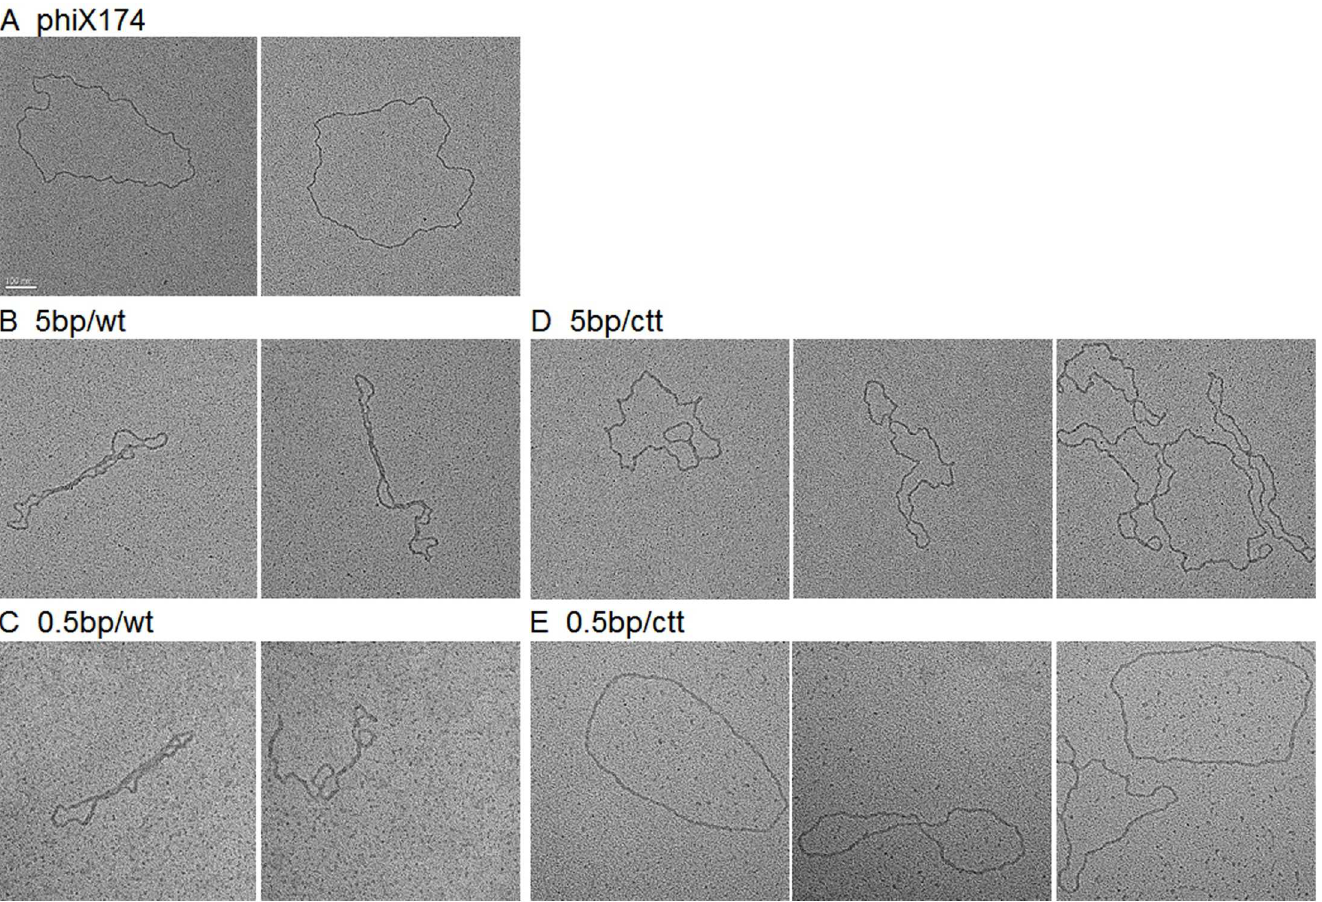
Fig 4. Electron micrographs of the phiX174 plasmid with or without the wild-type/C-terminally truncated Sso7c4 proteins. Representative images of Sso7c4-DNAcomplexes visualizedby EM. Nicked phiX174plasmidswere incubatedwith different stoichiometries (5 bp/dimeror 0.5 bp/dimer) of either the wild-type(wt) or C-terminally truncated (ctt) proteins. (A) High magnification images of the relaxed, circular phiX174 plasmid alone.(B) and (C) High magnification images of the wild-typeSso7c4-plasmid complex.(D) and (E) High magnification images of the C-terminally truncated Sso7c4-plasmid complex. The scale bar represents 100 nm.